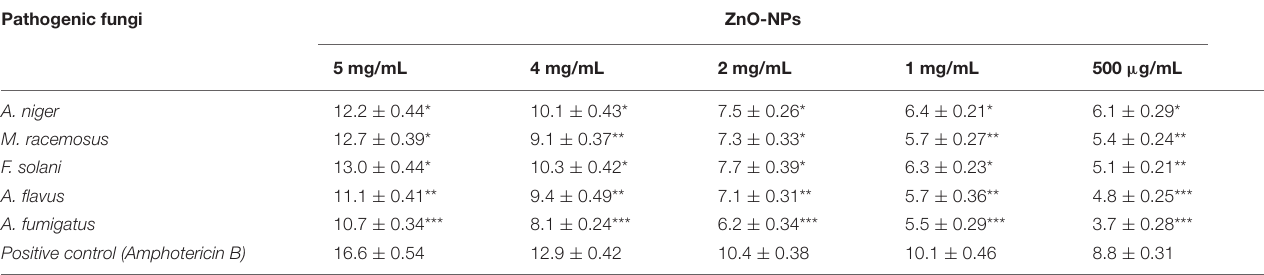
TABLE 4 | Antifungal activity of CeO 2 -NPs against pathogenic fungi. Pathogenic fungi